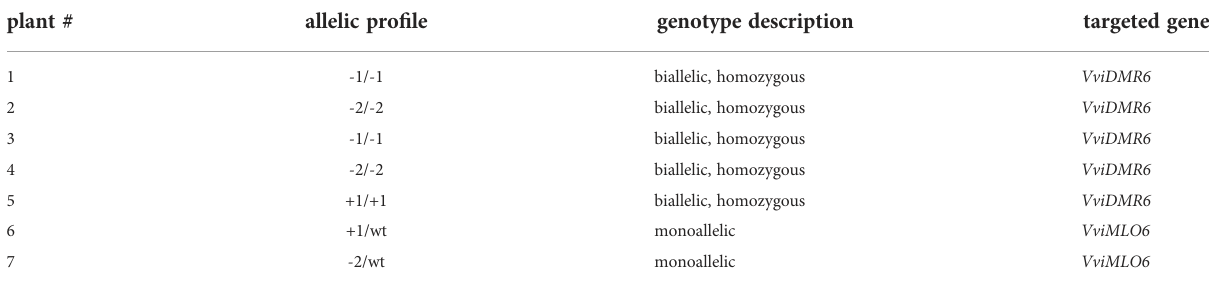
TABLE 3 Allelic pro fi le of the plants regenerated from protoplasts of Crimson seedless. Genotype of Crimson s. plants regenerated from protoplasts.